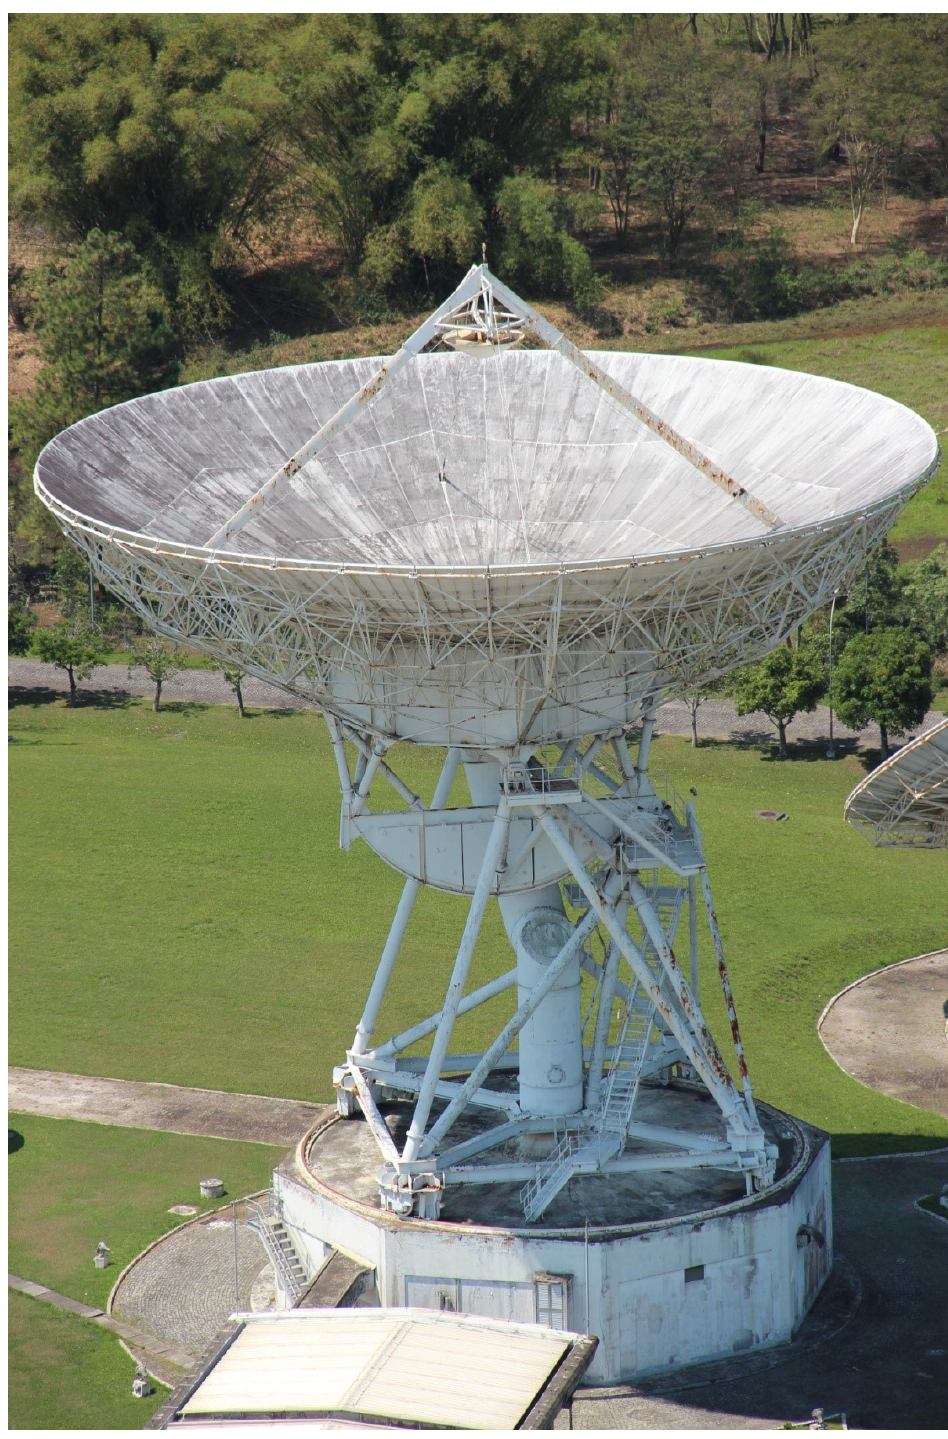
Figure 1. The Tanguá 32 m antenna (Rio de Janeiro State), planned to be part of IVIA.